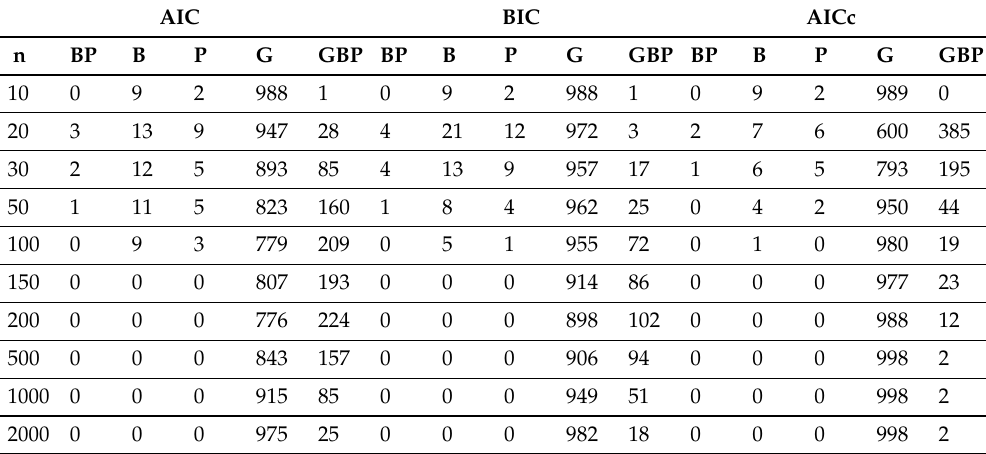
Table 9. Smaller AIC/BIC/AICc scores in 1000 simulations from a Gamma distribution G ( α , β ) with α = 0.5, β = 0.9.